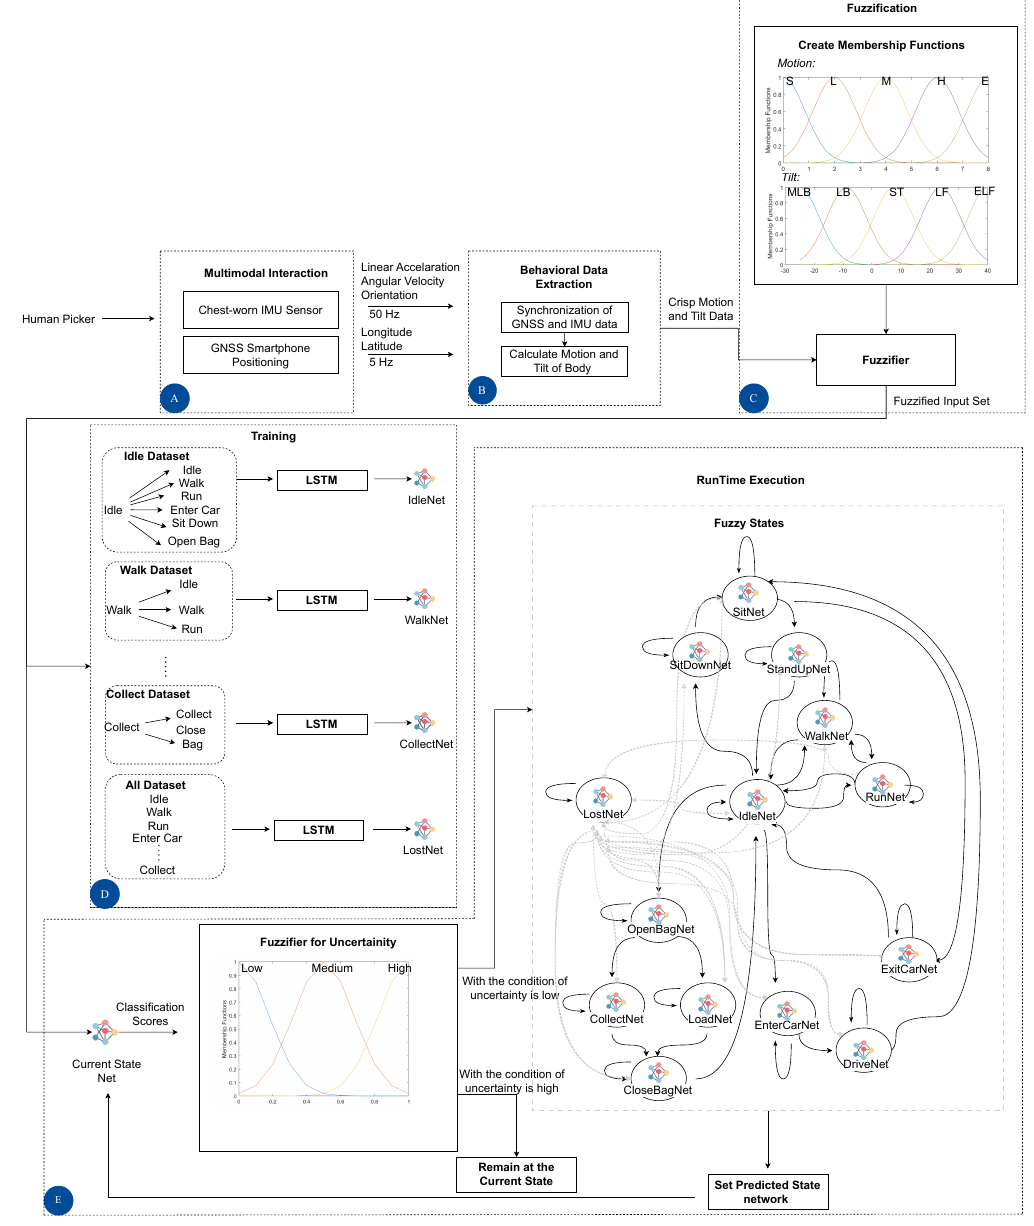
Figure 6. The diagram of the proposed